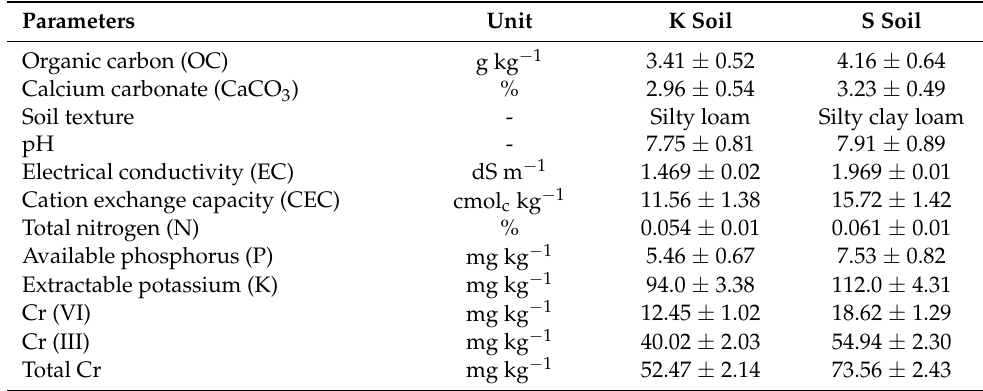
Table 2. Physico-chemical characterization of tannery polluted Kasur (K) and Sialkot (S) soils.